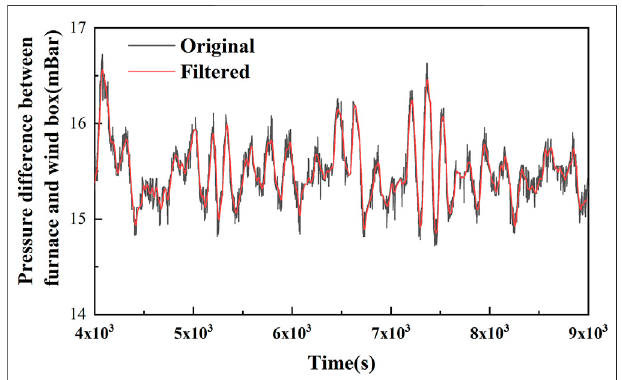
FIGURE 4 | Curves before and after FIR fi